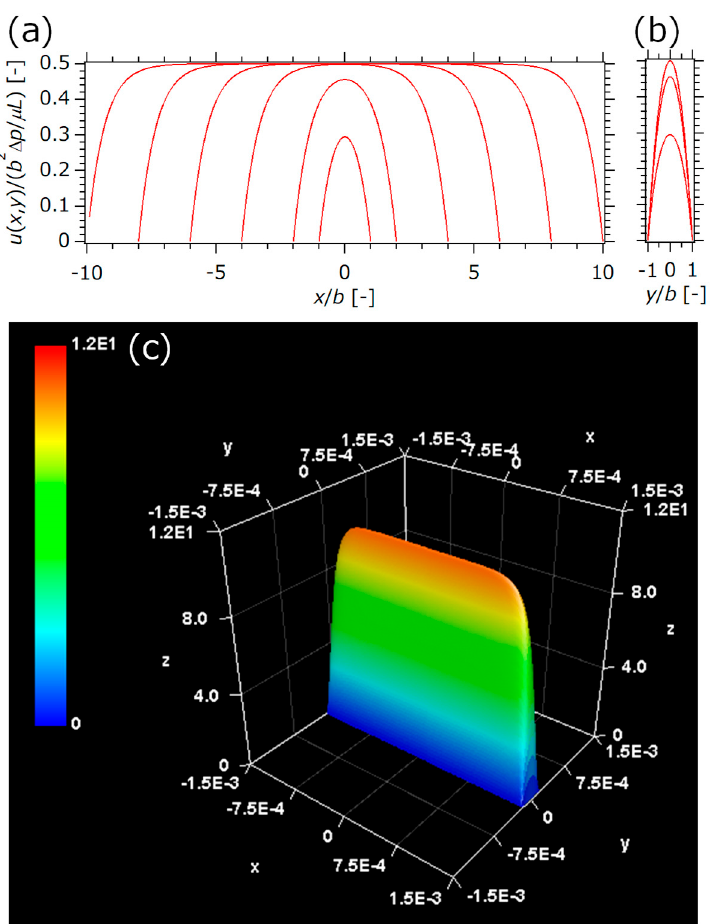
Figure 5. Analytical velocity distributions of rectangle channel: ( a ) dimensionless velocity in long side direction, ( b ) dimensionless velocity in short side direction, ( c ) 3D view of (2 a , 2 b , a 0.36 mm, 6.67) and ∆ p = 2.93 kPa. a of each line is 1, 2, 4, 6, 8, 10 in order from inside to outside in ( a , b